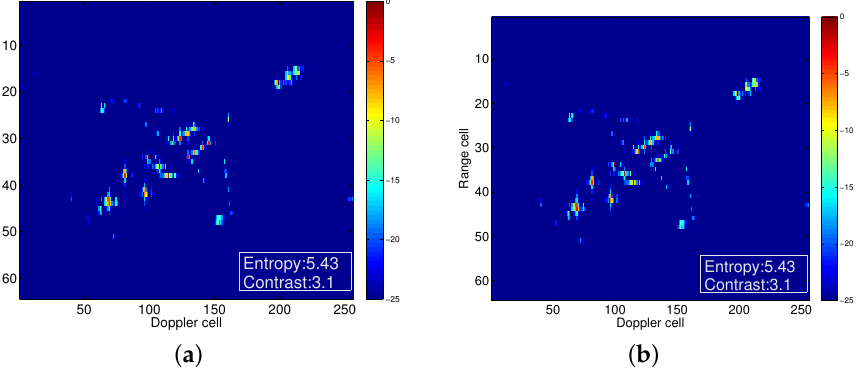
Figure 9. ISAR images of Boeing B727 aircraft. ( a ) ISAR image based on adaptive MFT. ( b ) ISAR image based on adaptive MFT with DFS